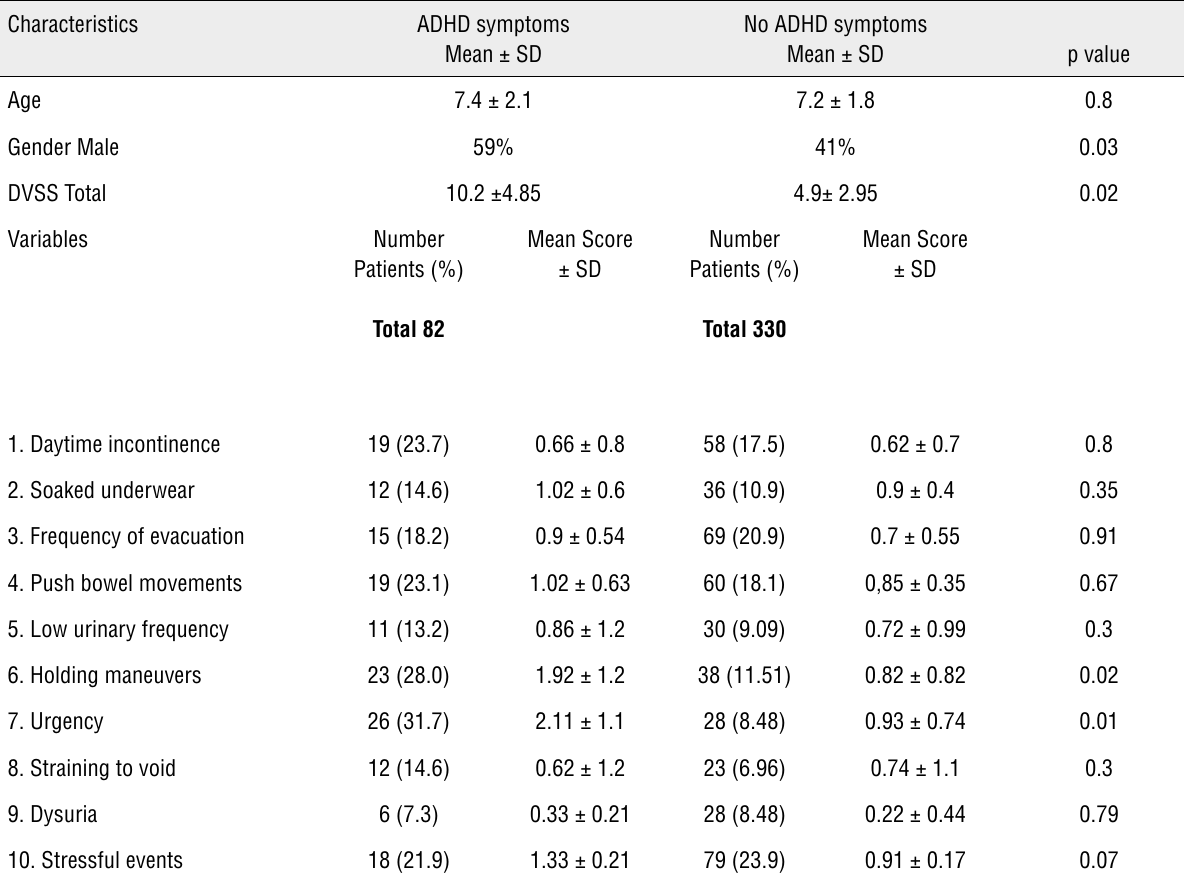
Table 1 - Description of Lower Urinary Tract Symptoms (LUTS) in Children and Adolescents with Attention-Deficit Hyperactivity (ADHD)